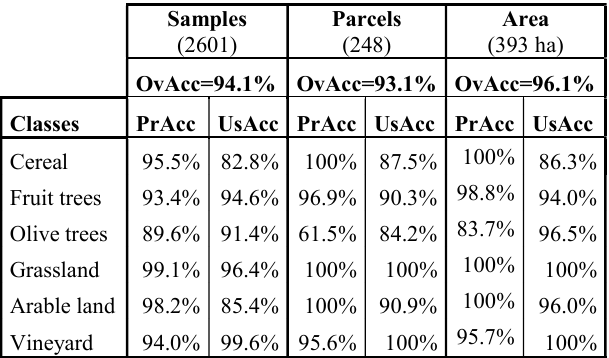
Table 2. Crop type classification results using the proposed CNN, presented in terms of samples, parcels and area-based.